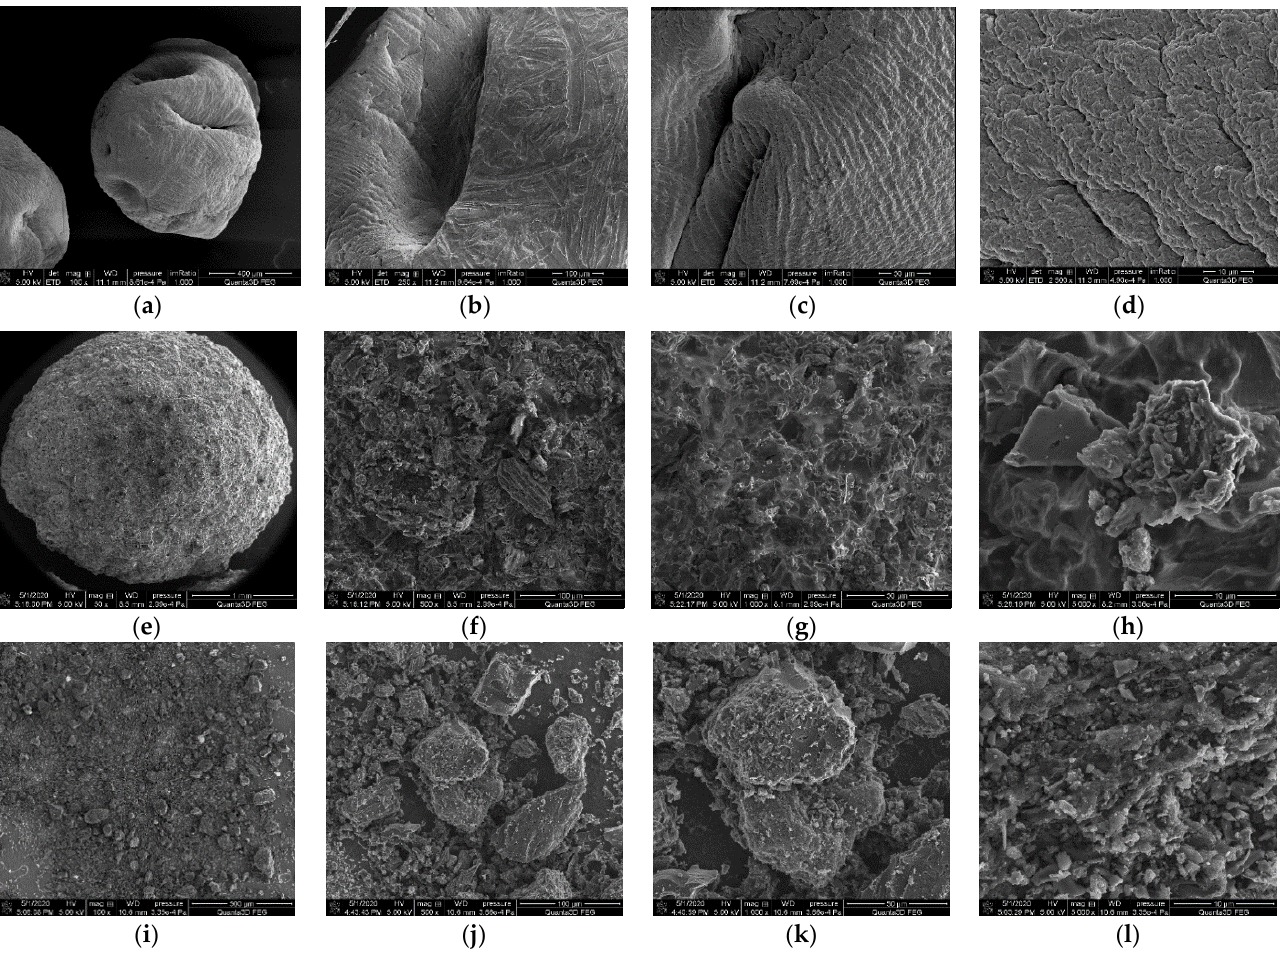
Figure 3. SEM micrographs ALGCa [magnifications: 100—( a ), 250—( b ), 500—( c ), 2500—( d )], ALG_C8 [magnifications: 50—( e ), 500—( f ), 1000—( g ), 5000—( h ) and C (magnifications: 100—( i ), 500—( j ), 1000—( k ), 5000—( l )].